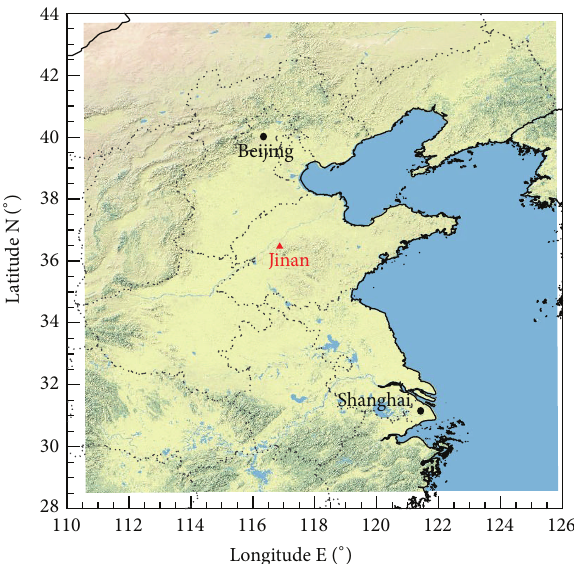
Figure 1: Topographic map of North China which shows the study area of